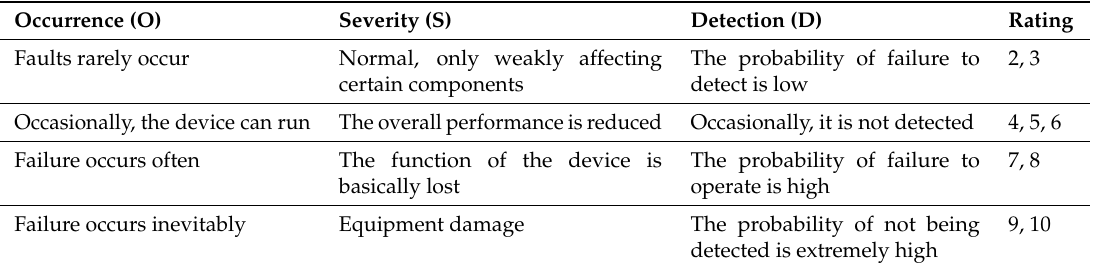
Table 1. Three parameters O, S, and D scoring criteria of Fuzzy Failure Mode and Effects Analysis